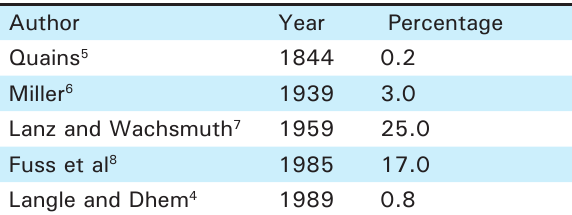
Table 1. Prevalence of Superficial Brachial